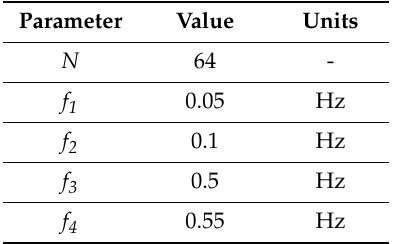
Table 2. Parameters of the considered Hilbert filter.